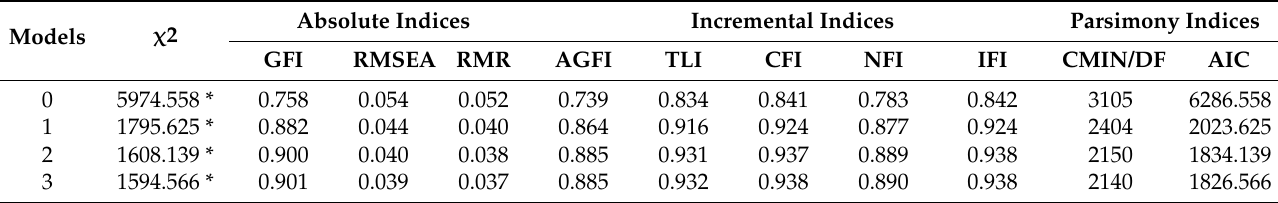
Table 5. Absolute, incremental, and parsimony indexes for the known models.